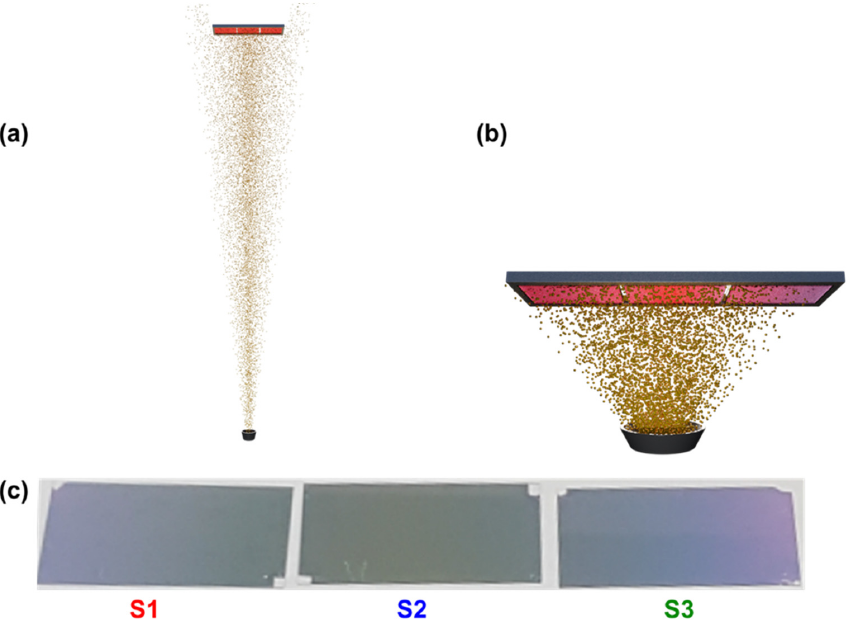
Figure 5. ( a ) Schematic of vacuum evaporator for metal deposition in the conventional method (for